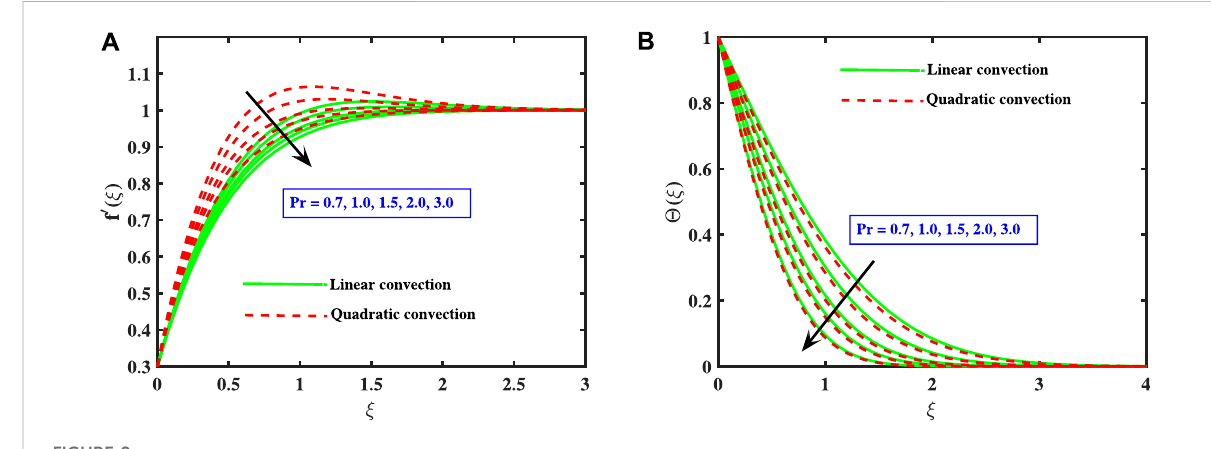
FIGURE 8 The Θ ( ξ ) and f ′ ( ξ ) curves for distinct Pr values.